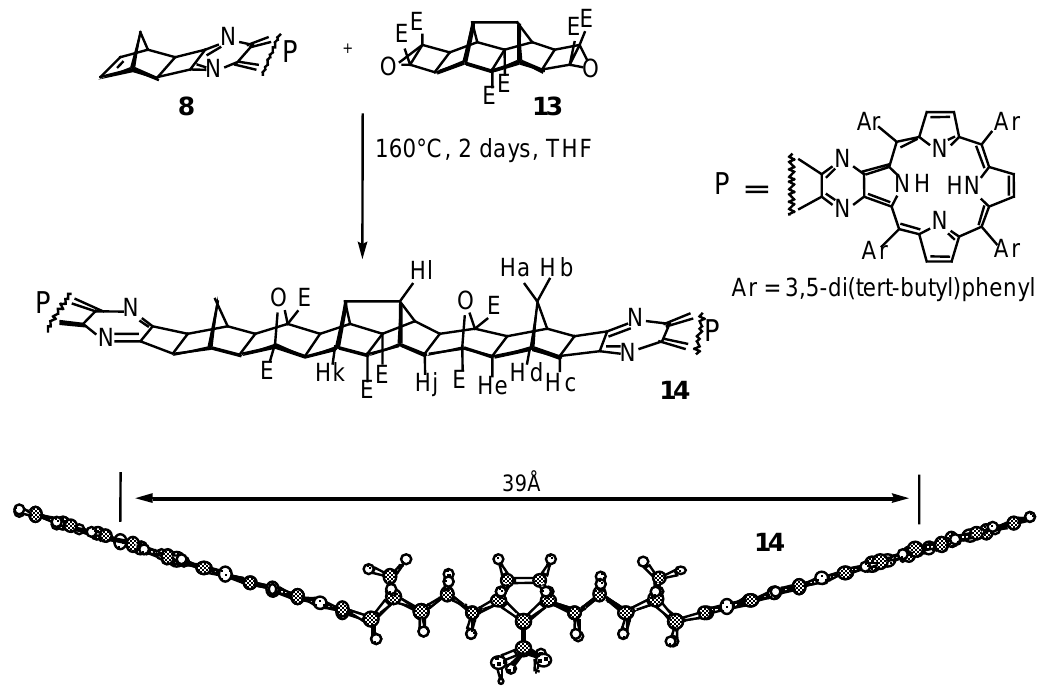
) of bis -porphyrin cavity 12 3